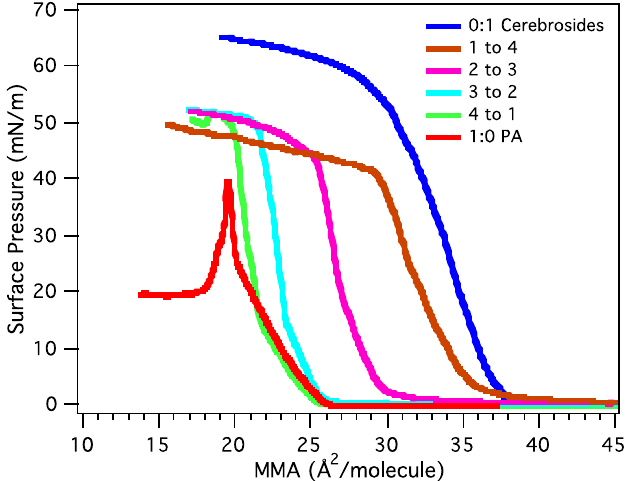
Figure 4. π -A isotherms of mixed PA/cerebrosides monolayers with various compositional ratios on